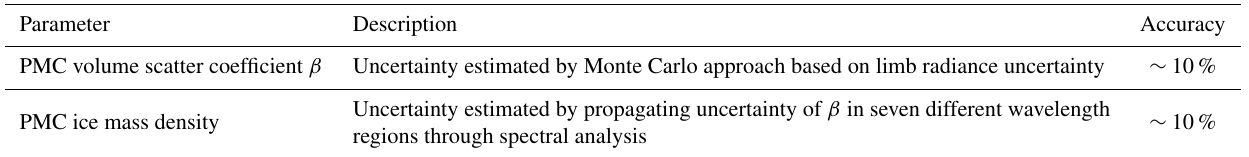
Table 1. Summary of OSIRIS PMC uncertainties.